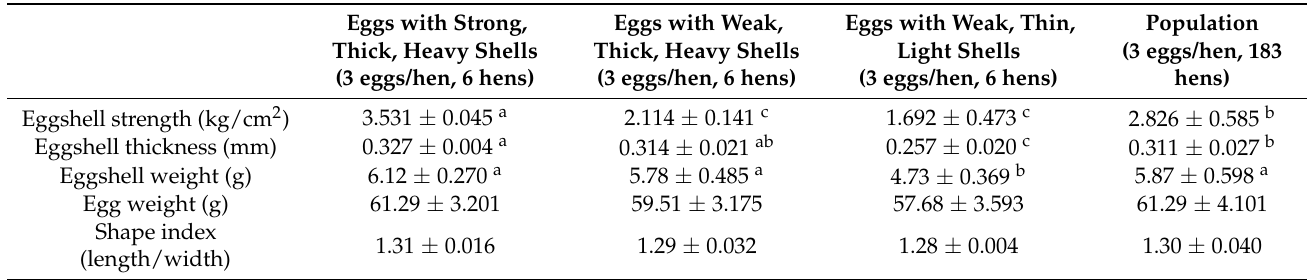
Table 1. Comparison of eggshell quality traits of eggs laid by selected hens from the 3 groups.